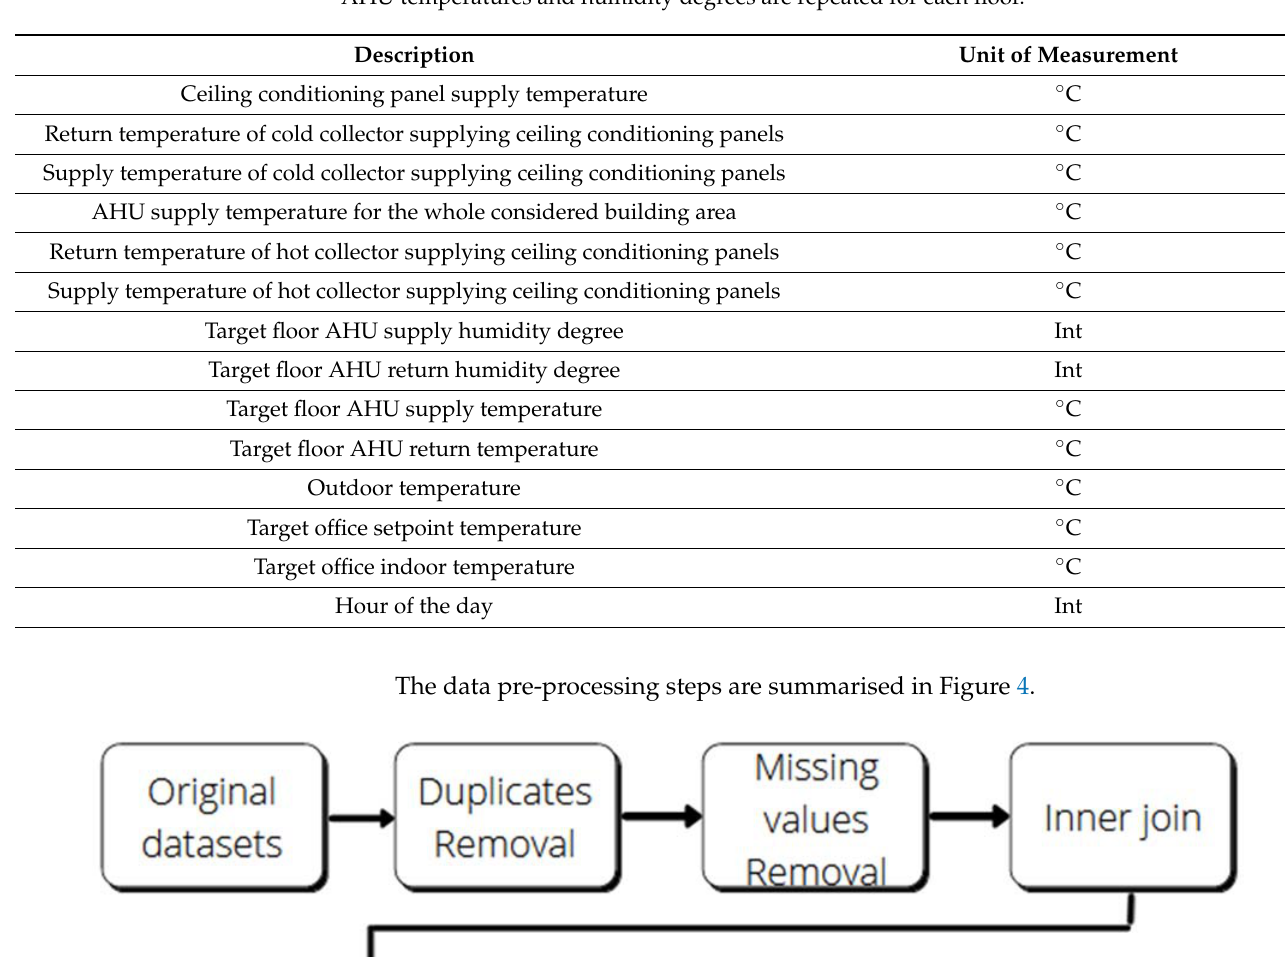
Table 1. Recap of the selected feature. Note that setpoint temperatures and indoor temperatures can be found five times per floor because they are repeated for each office on each floor. Note also that AHU temperatures and humidity degrees are repeated for each floor.